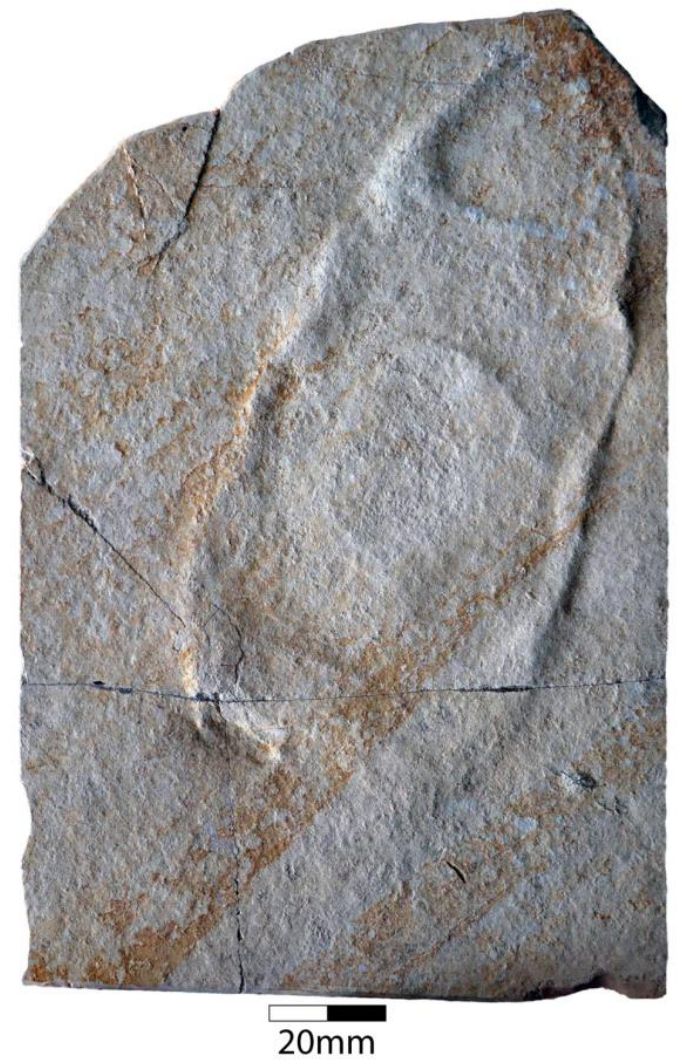
Figure 33. Putative batomorph type egg capsule from the Solnhofen Archipelago. † Rajitheca sp. Steininger, 1966 [322] (private